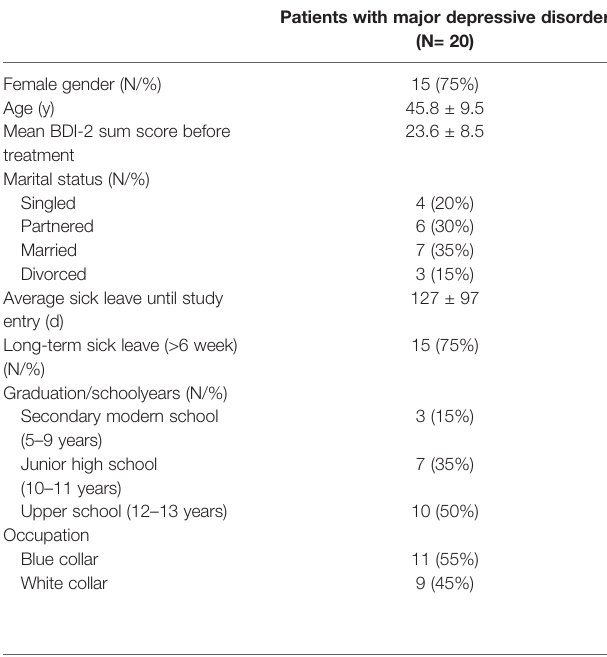
TABLE 1 | Baseline data of depressed patients included in the study. Patients with major depressive disorder (N=